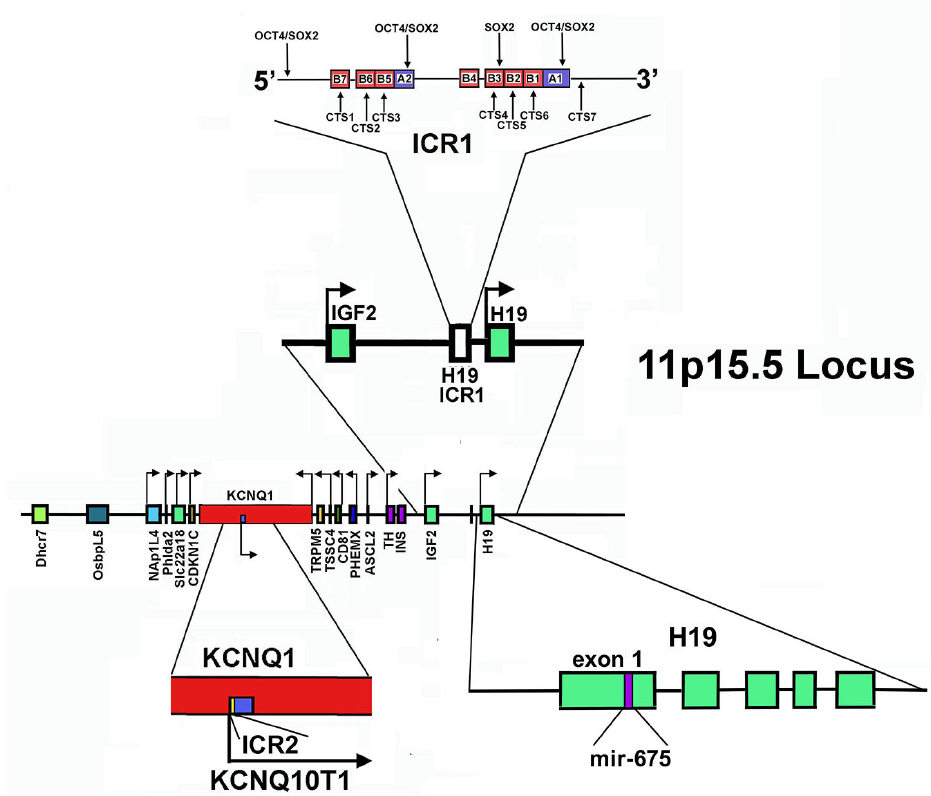
Figure 2. Structure of 11p15.5 locus. The Figure shows the gene mapping at the 11p15.5 locus (in the center). In addition, the direction of transcription is reported. At the top: the localization and the structure of ICR1, as well as the transcription factors interacting with this sequence, are reported. At the bottom: on the left, the organization of ICR2 and KCNQ1OT1 is shown; on the right, the localization of the mir-675-coding sequence in the first exon of the H19 gene is evidenced. In the telomeric domain, also called the H19/IGF2 domain, ICR1 acts as a chromatin insulator, separating H19 and IGF2 genes and controlling their reciprocal imprinting